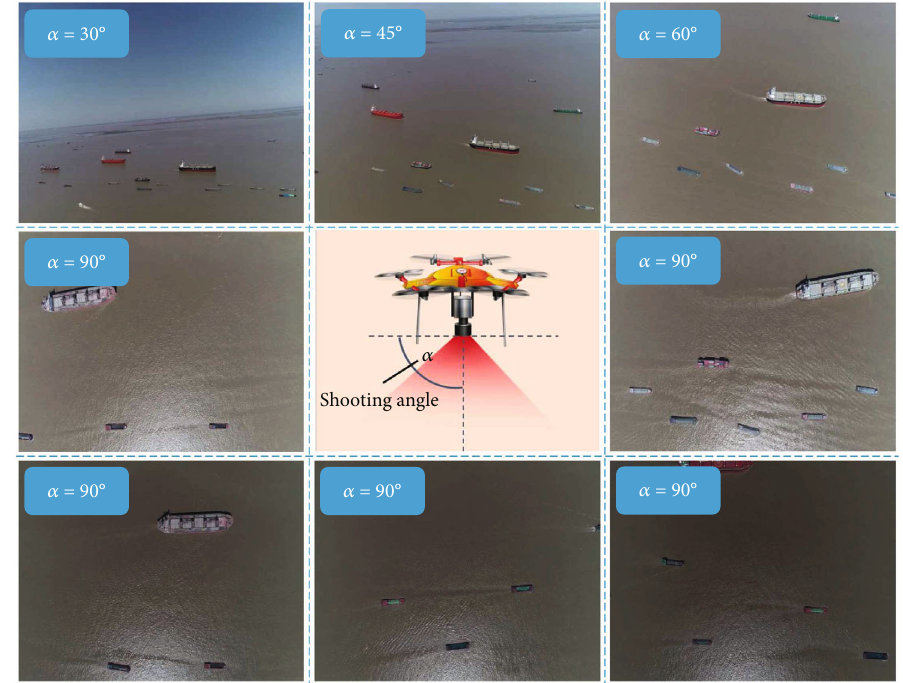
Figure 8: Self-built ship